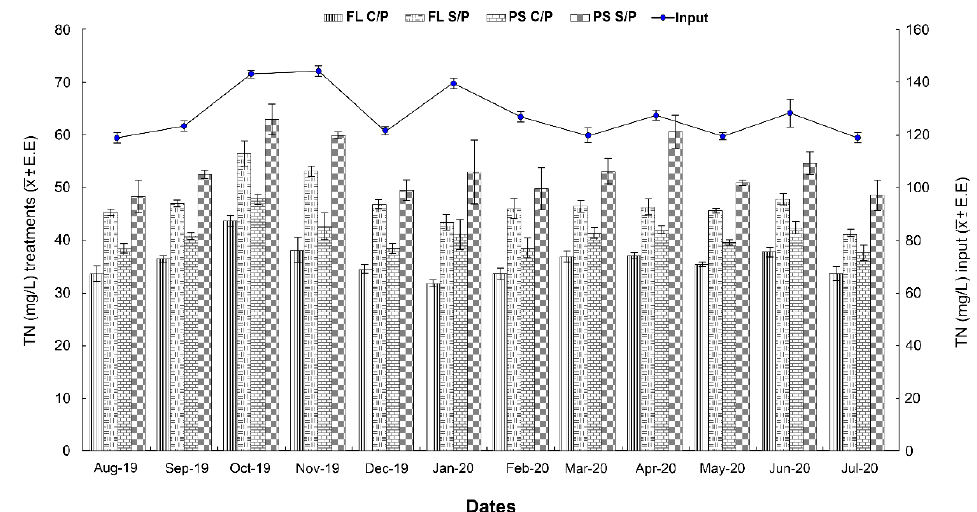
Figure 9. Average TN concentrations ( ± E.E.) during the experiment. (FLCP: free flow with plant; FLSP: free flow without plant; PSCP: saturated flow with plant; PSSP: saturated flow with plant; E.E.: standard error).